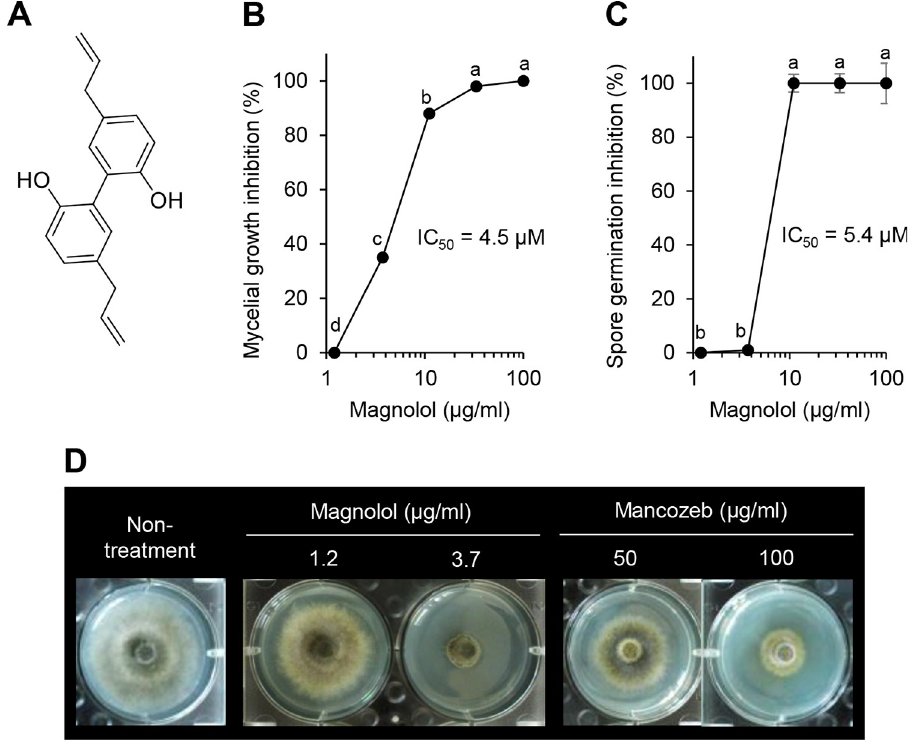
Fig 3. Effects of magnolol on spore germination and mycelial growth of Alternaria porri . (A) Chemical structure of the antifungal compound CB1 (magnolol). (B) Mycelial growth inhibition. The colony diameter was measured at 7 dpi, and the inhibition ratio (%) was calculated by comparison with non-treatment controls. (C) Spore germination inhibition. The number of germinated spores was counted in a total of 100 spores at 10 h after the magnolol treatment. (D) Representative colony morphology of A . porri grown on PDA supplemented with magnolol or mancozeb. For the non-treatment control, PDA containing 1% methanol was used. The values represent the mean ± standard deviation of two runs with three replicates. Different letters indicate significant differences at p <